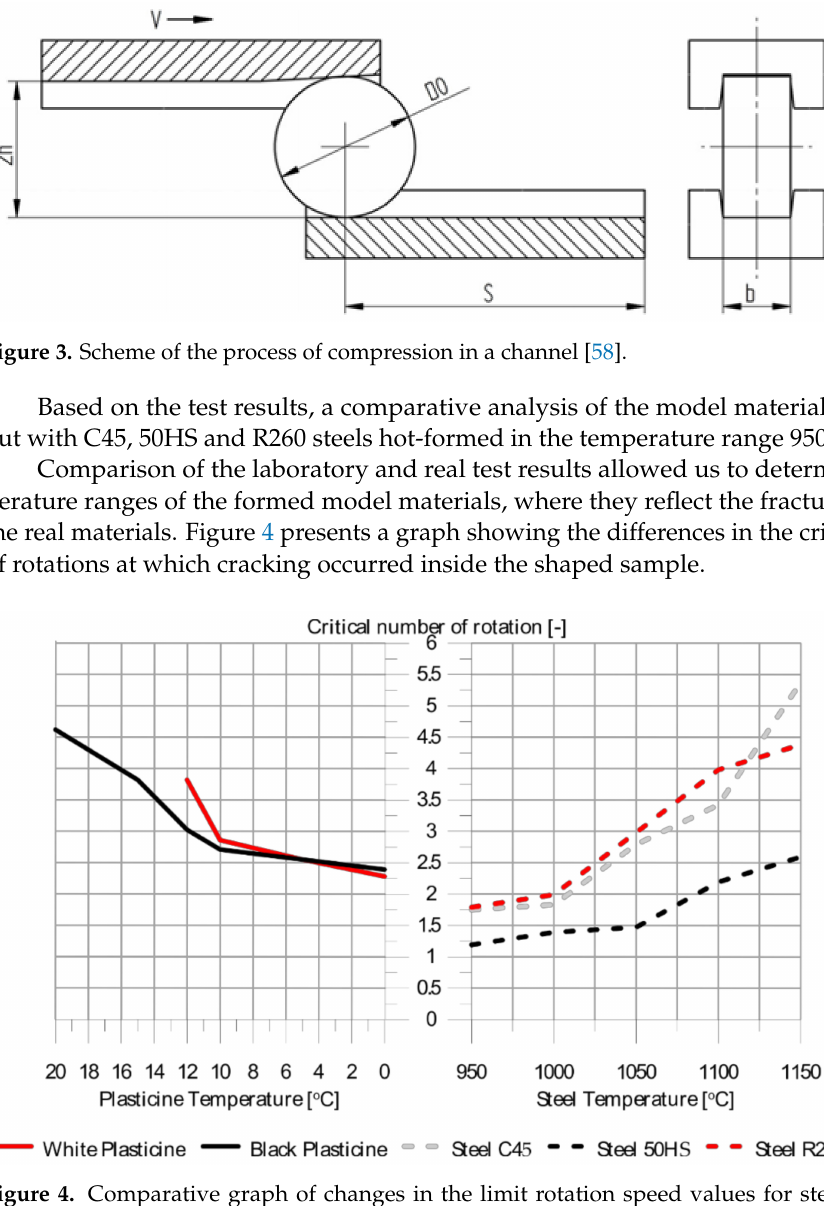
Figure 4. Comparative graph of changes in the limit rotation speed values for steel and model materials